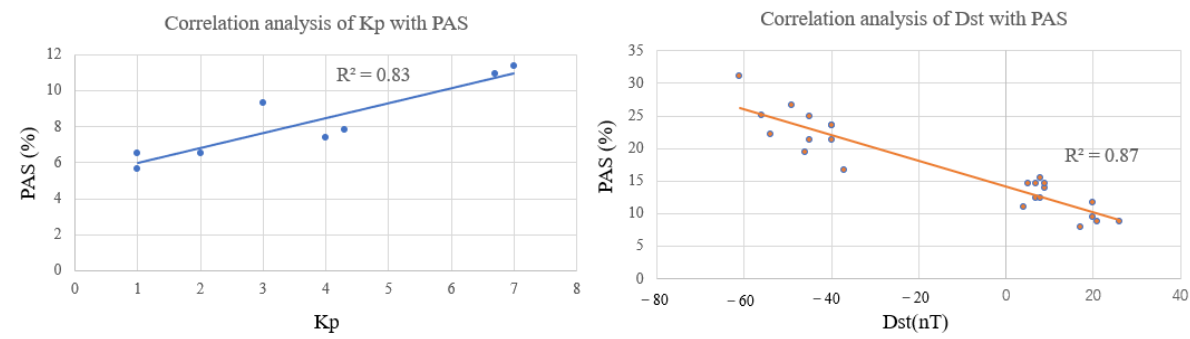
Figure 10. Correlation analysis between the PAS index and the geomagnetic indices Kp, Dst.